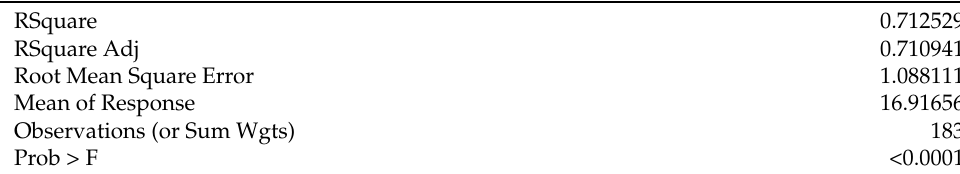
Table 4. Summary of fit—analysis of parameters O 2 and CO 2 dependencies.